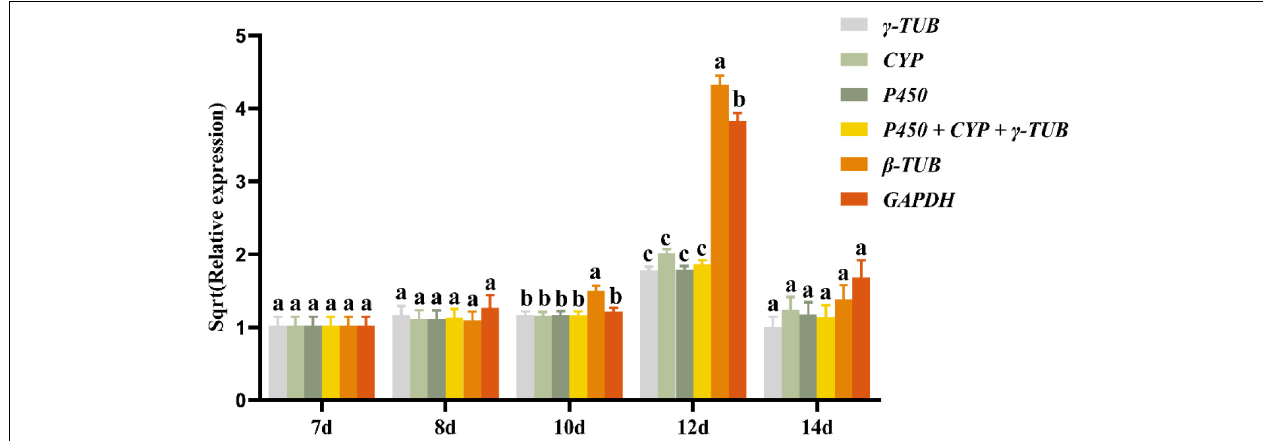
FIGURE 4 | Relative expression levels of laccase1 normalized by P450 , CYP , γ -TUB , GAPDH , and β -TUB . Different letters indicate the significant differences of laccase1 expression levels [analysis of variance (ANOVA), HSD, p < 0.05]. Sqrt (Relative expression) represents the square root of the relative expression